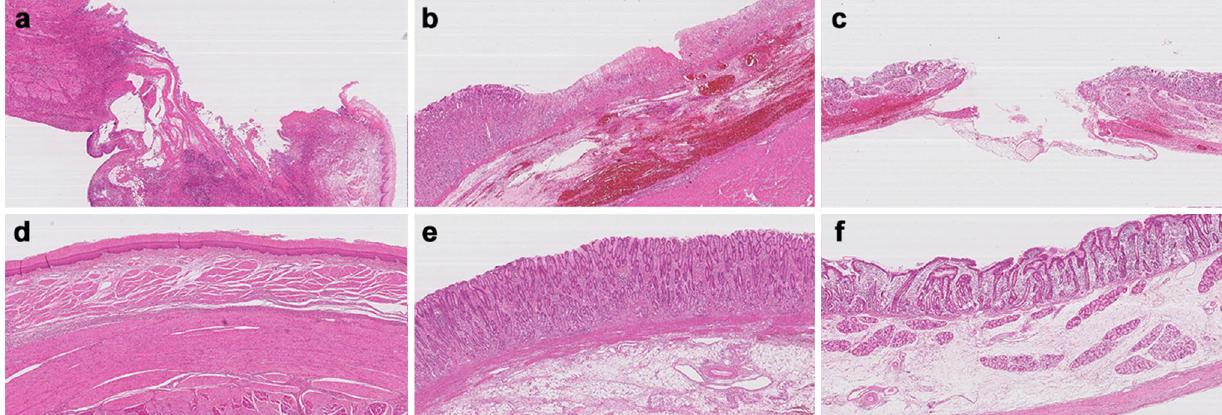
Figure 3. Histologic findings of adverse events in the phase 1 study. ( a ) Partial loss of the muscularis propria and surrounding inflammation with necrotic changes were exhibited at the ablation site of the esophagus treated with 2500 V (1190.5 V/cm). Hematoxylin and eosin (H&E), 20 × magnification. ( b ) Diffuse mucosal necrosis with extensive hemorrhaging in the submucosal layer were observed after ablation of the stomach at 2000 V (2000 V/cm). H&E, 40 × magnification. ( c ) The muscularis propria and submucosal layers showed complete destruction and submucosal hemorrhaging with congestion with ablation of the duodenum at 2000 V (952.4 V/ cm). H&E, 20 × magnification. ( d ) normal esophagus. ( e ) normal stomach. ( f ) normal duodenum. H&E, 40 ×